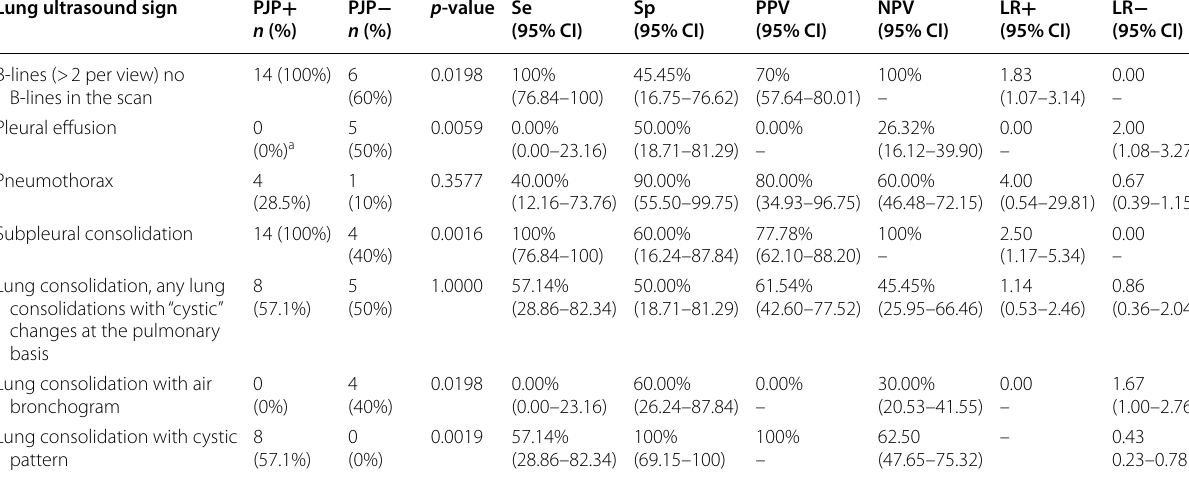
3), TB (n 3), disseminated Cytomegalovirus infection (n = = 1) and adenocarcinoma (n =